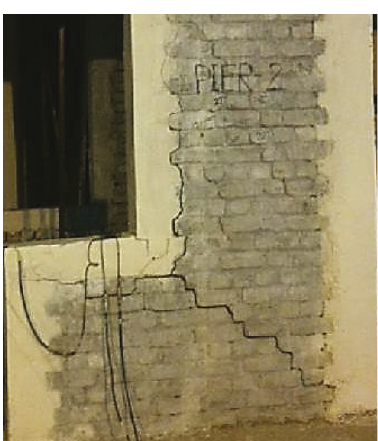
Figure 9: Diagonal shear cracks in pier 2 corresponding to story drift of 0.73%.